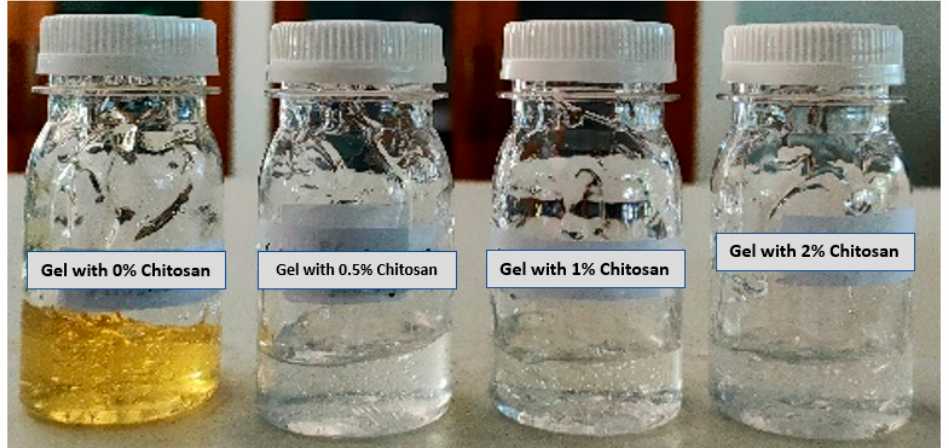
Figure 9. Hand sanitizer gel with different formulations containing silver nanoparticles and silver nanoparticles coated by chitosan with different chitosan concentrations.